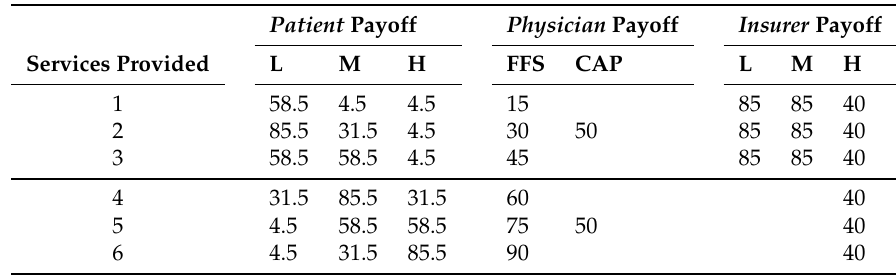
Table 7. Payoff of